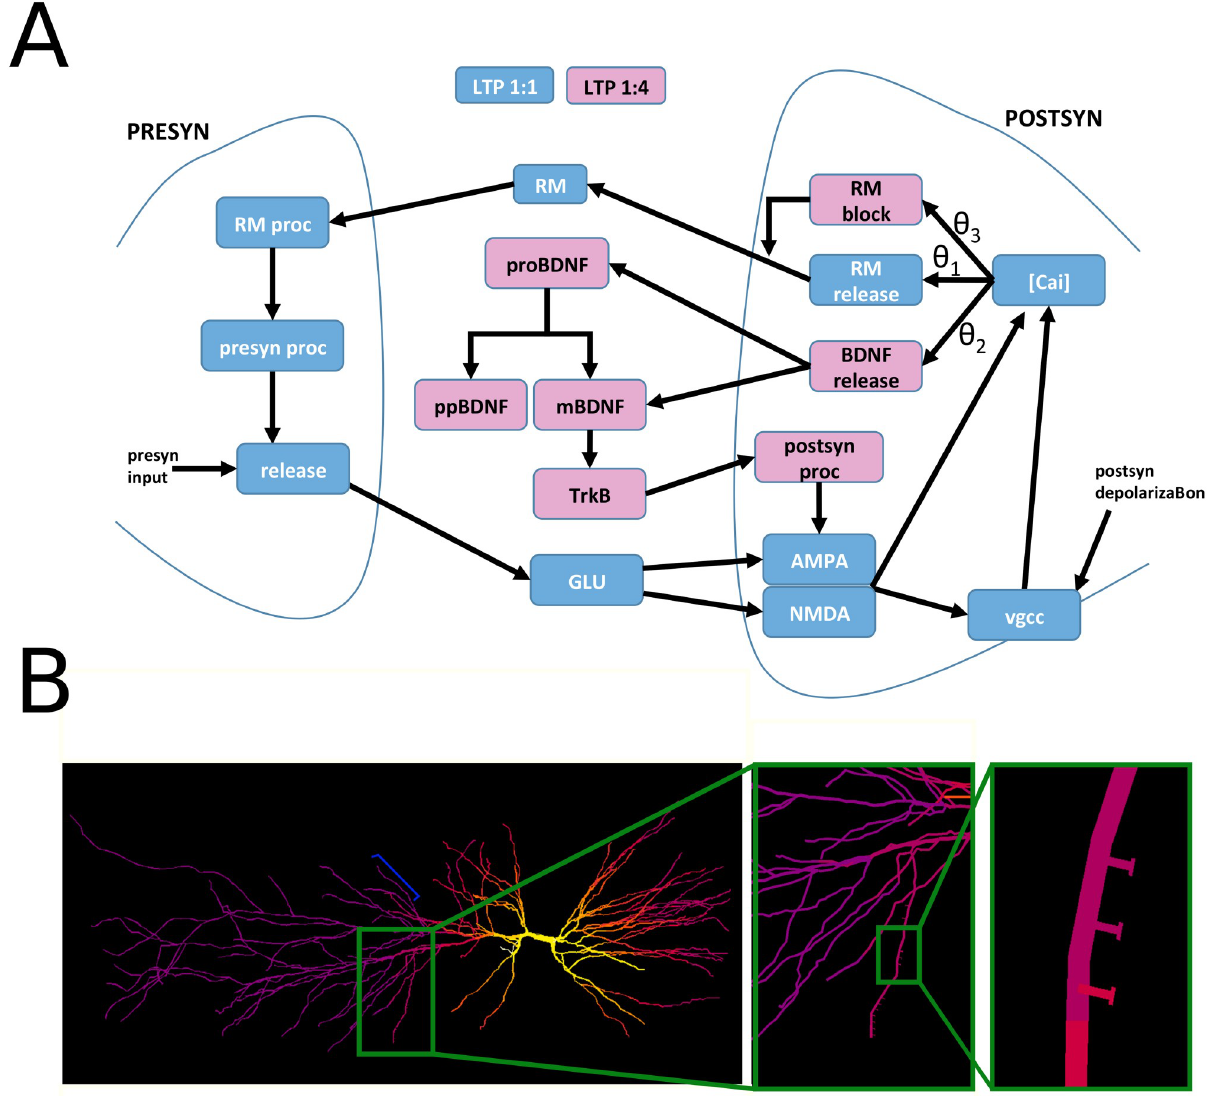
Fig 2. Schematic representation of our model for the BDNF-dependent t-LTP signaling cascade. A) For clarity, the biomolecular pathways involved with the 1:1 t-LTP or 1:4 t-LTP induction protocols are represented with blue and pink blocks, respectively. The model inputs are a synaptic activation ("presyn input", on the left) and a postsynaptic depolarization (on the right). The 70x 1:1 t-LTP cascade (blue) is activated if, during the train of stimuli, the [Ca 2+ ] i in the spine crosses the θ 1 threshold frequently enough to allow RM to activate presynaptic RM-dependent processes ( RM proc ). This, in turn, will activate a pre-synaptic signaling cascade leading to the increase in glutamate release. The 25x 1:4 t-LTP cascade (pink) is activated by [Ca 2+ ] i transients above θ 2 , which trigger a delayed (0–300 s) fusion of vesicles containing mBDNF and proBDNF. The mBDNF activates the postsynaptic TrkB receptors that finally activate an intracellular, post-synaptic, signaling cascade leading to an increase of AMPA peak conductance; [Ca 2+ ] i transients above θ 3 , will result in a block of RM release. B) The CA1 model neuron used for all simulations, shown during the initial phase of an action potential backpropagating from the soma; the dendritic segments are color-coded for membrane potential (yellow represents a membrane potential above -20mV, purple represents -70mV). The insets show the location of 12 spines on a dendritic branch (branch38 of model morphology [30]). Six additional spines were placed on a different dendritic branch (branch8 of model morphology [30] indicated by the blue bracket on the left plot). where δ ( t ) is a delta function, t was the time of arrival of a spike at the pre-synaptic termi- spike nal, the variables x , y , and z are the fraction of resources in the recovered, active, and inactive states, respectively, and U was proportional to the glutamate released by each synaptic stimu- SE lation. They reproduced the stereotypical synaptic response dynamics between pyramidal